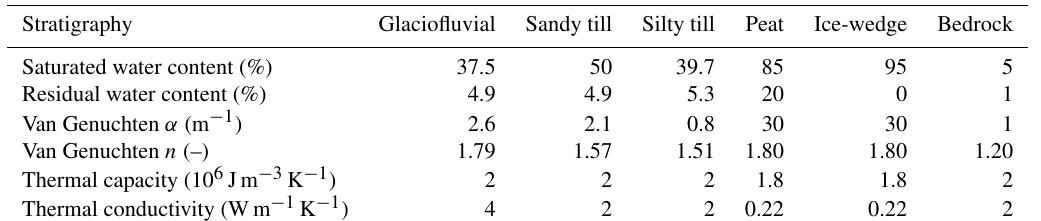
Figure 5. The 10 terrain types used to partition the landscape and observations. Table 2. GEOtop soil parameters used to simulate different stratigraphic units.